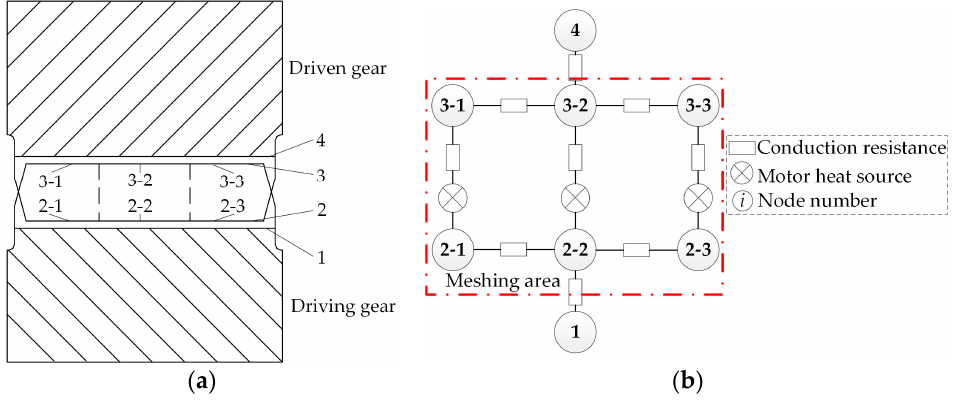
Figure 13. Optimization model of the reducer. ( a ) Gear meshing area; ( b ) The refined thermal network model.